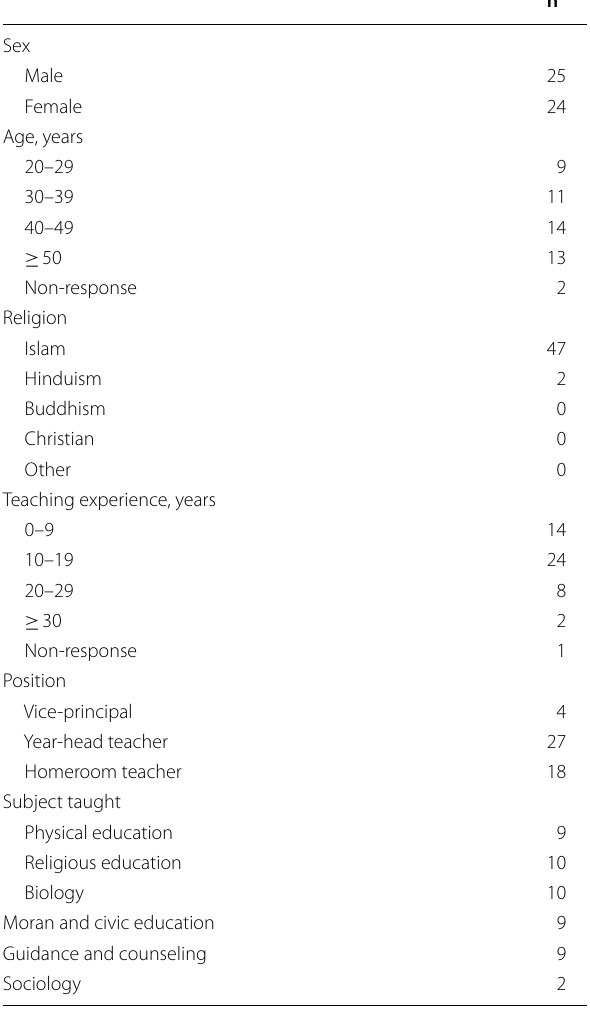
Table 1 Characteristics of the teachers ( N